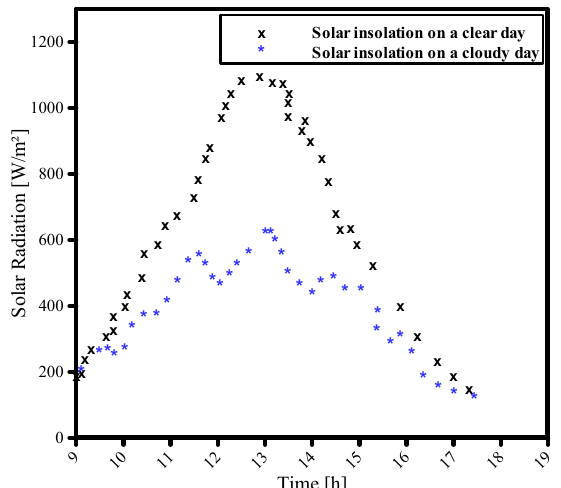
Figure 11. Solar irradiation data collected on a cloudy day and a clear day for the experimental test.